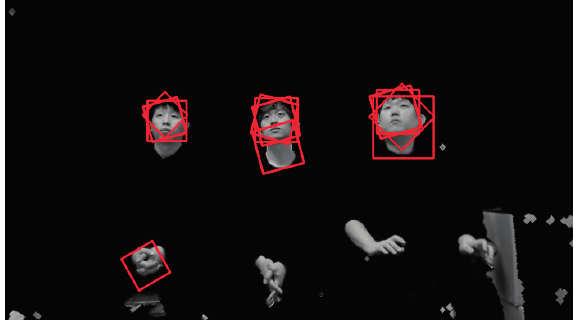
Figure 7. Multiple face boxes in the same face region.